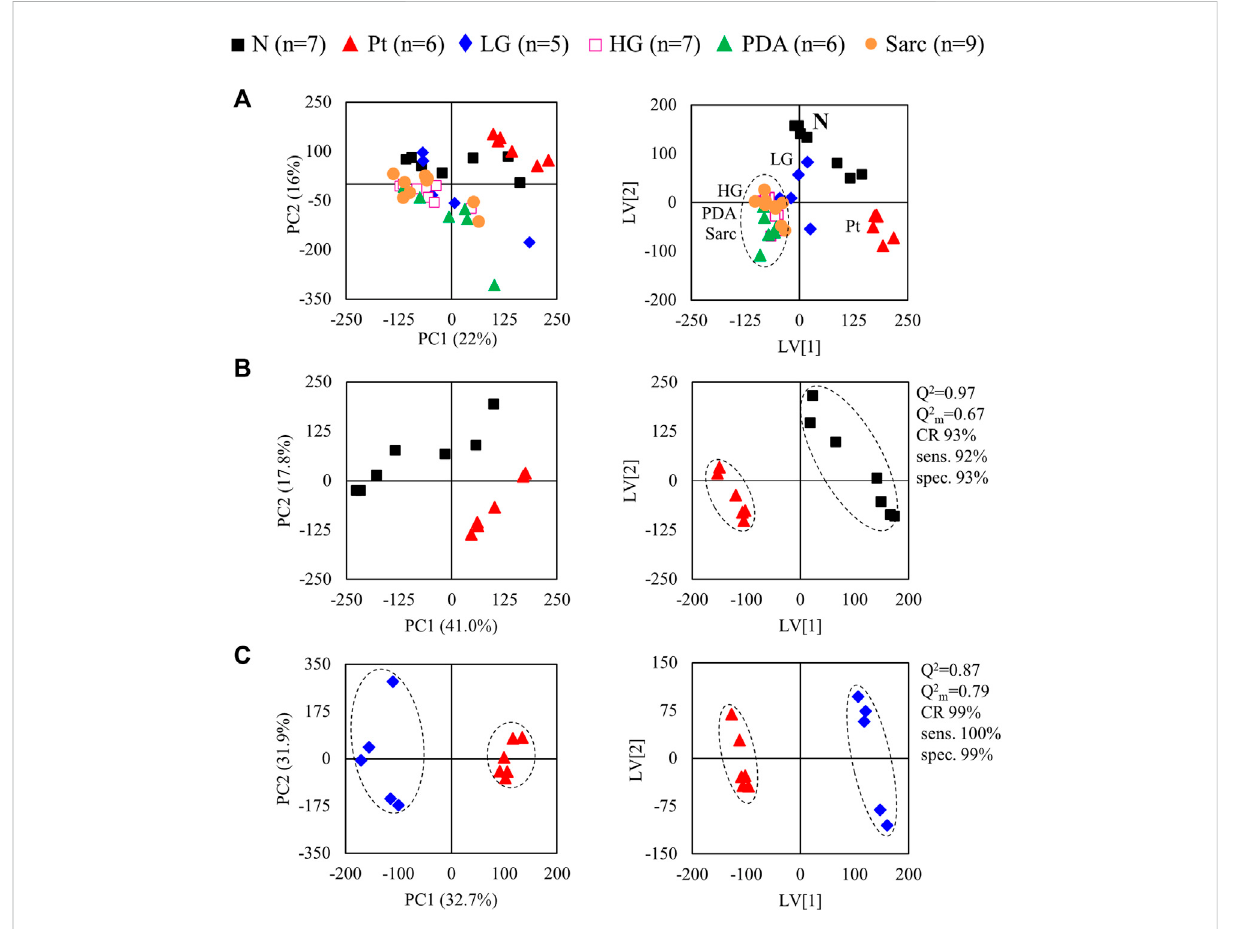
FIGURE 2 PCA (left) and PLS-DA (right) scores scatter plots for 1H NMR spectra (normalized to total area) of (A) all samples: controls, ■ N ( n = 7), ▲ (red) pancreatitis,Pt( n =6), ◆ (blue)LGPanINlesions( n =5), □ (pink)HGPanINlesions( n =7), ▲ (green)pancreaticductaladenocarcinoma,PDA( n =6), C (orange)sarcomatoidcarcinoma,Sarc( n =9),and (B) Ptvs.Normaltissue,and (C) Ptvs.LGlesionstissue.Q 2 ,predictivepowerofPLS-DAmodel;CR, classi fi cation rate; sens., sensitivity; spec., speci fi